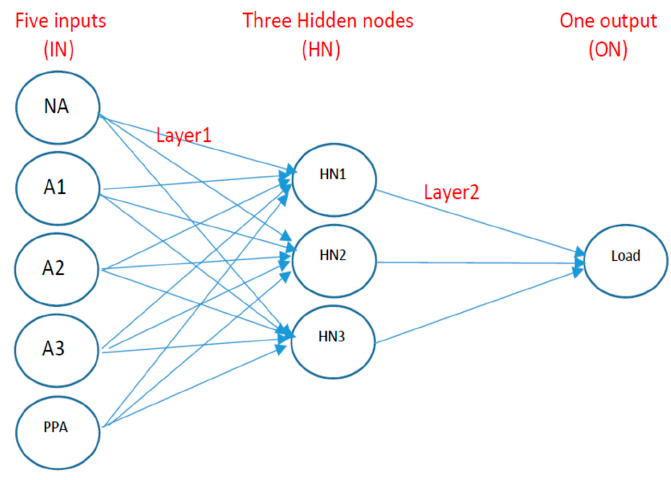
Figure 6. Artificial neural network (ANN) model with 5 IN–3 HN–1 ON with layer 1 (L1) and layer 2 (L2) as transfer functions.